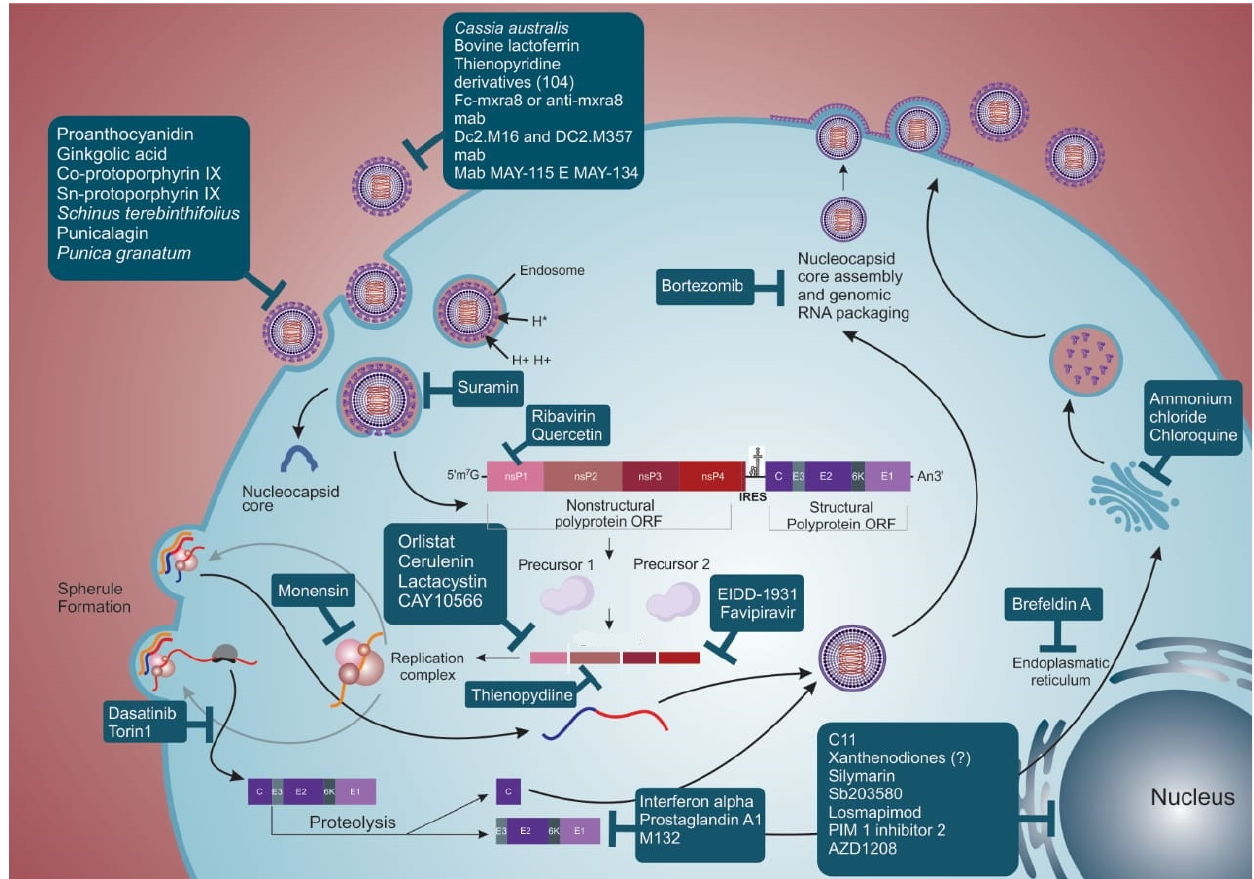
Figure 3. MAYV replication cycle and anti-MAYV compounds. Compounds with anti-MAYV activity are described at different time points of viral replication. Proanthocyanidin, ginkgolic acid, Co and Sn-protoporphyrin IX, schinus terebinthifolius, and punicalagin from Punica granatum have virucidal action. The compounds of Cassia australis , bovine lactoferrin, thienopyridine derivatives (no. 104), and the antibodies Fc-Mxra8 and anti-Mxra8, DC2M16 and DC2M357, MAY-115 and MAY-134 prevent adsorption of the viral particle. Suramin acts by blocking fusion during the viral internalization step. Ribavirin appears to interact with viral RNA before initiating replication, and quercetin acts to inhibit viral RNA metabolism. Some compounds interact with non-structural proteins, such as orlistat, cerulenin, CAY10566, and lactacystin that interact with nsP1; thienopyridine interacts with protease (nsP2); EIDD-1931 and favipiravir interact with nsP4. Monensin and epicatechin act during viral replication. Dasatinib and torin-1 inhibit the translation of subgenomic mRNA. M132 interferes during the synthesis of E1 and nsP1, possibly by compromising the action of lysosomal cysteine proteases. Interferon alpha inhibits the protein synthesis of envelope glycoproteins, possibly by increasing intracellular pH, compromising protein traffic. Prostaglandin A1 also interferes with the synthesis of envelope glycoproteins by acting on the synthesis of HSP70. Brefeldin A blocks the transport of envelope proteins in the endoplasmic reticulum. Ammonium chloride and chloroquine act on the Golgi complex, shifting the pH of the organelle and preventing the transport of glycoproteins to the cell membrane. Bortezomib interferes with the ubiquitination of the viral capsid, preventing the packaging of replicated viral RNA. Some compounds also target host factors like C11 (STING antagonist and IRF3 phosphorylation), xanthenodiones (intracellular event not determined), silymarin (oxidative stress modulation), SB203580 and losmapimod (p38 protein suppressors), PIM1 inhibitor 2 and AZD1208 (which interferes with the negative regulation of interferon-stimulated, like PML, OASL, and TRIM5 genes).